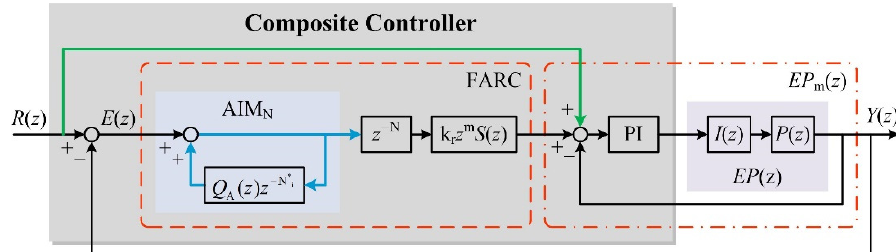
Figure 10. Schematic diagram of the composite controller.